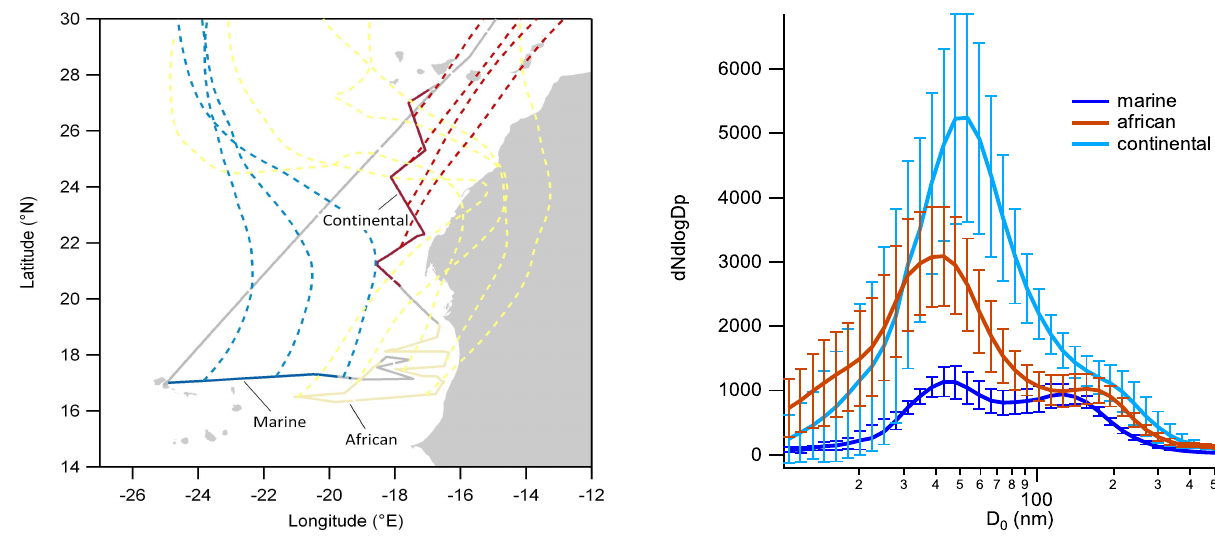
Fig. 2. The average number size distribution for each of the 3 study periods.